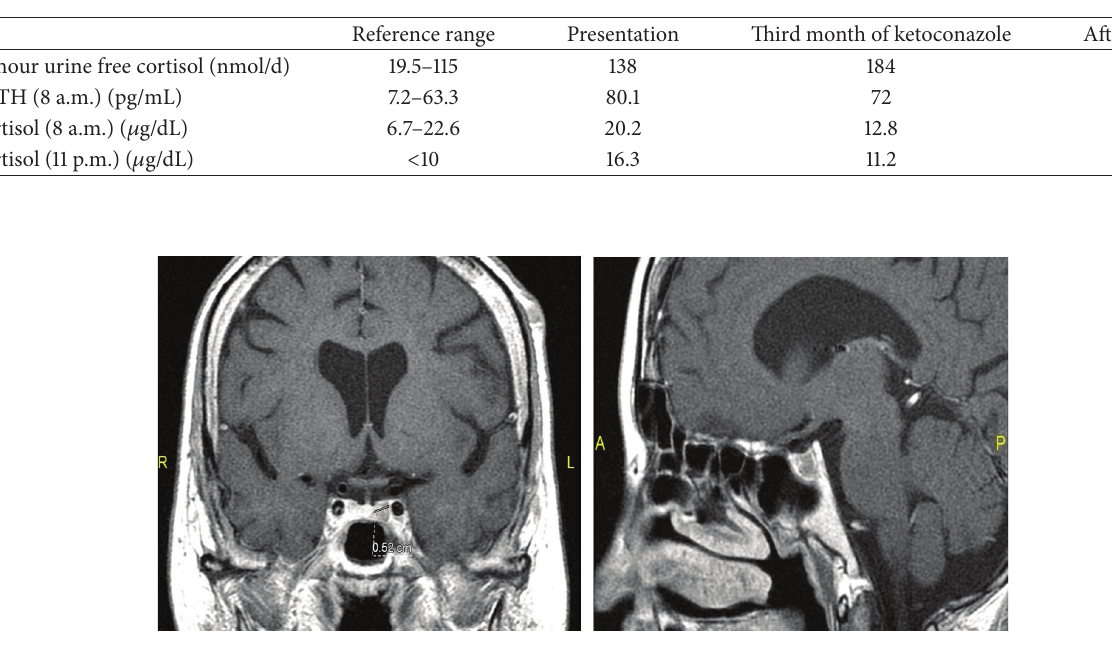
Figure 1: Coronal and sagittal T1-weighted image, showing a 5mm microadenoma at the left side of pituitary gland.